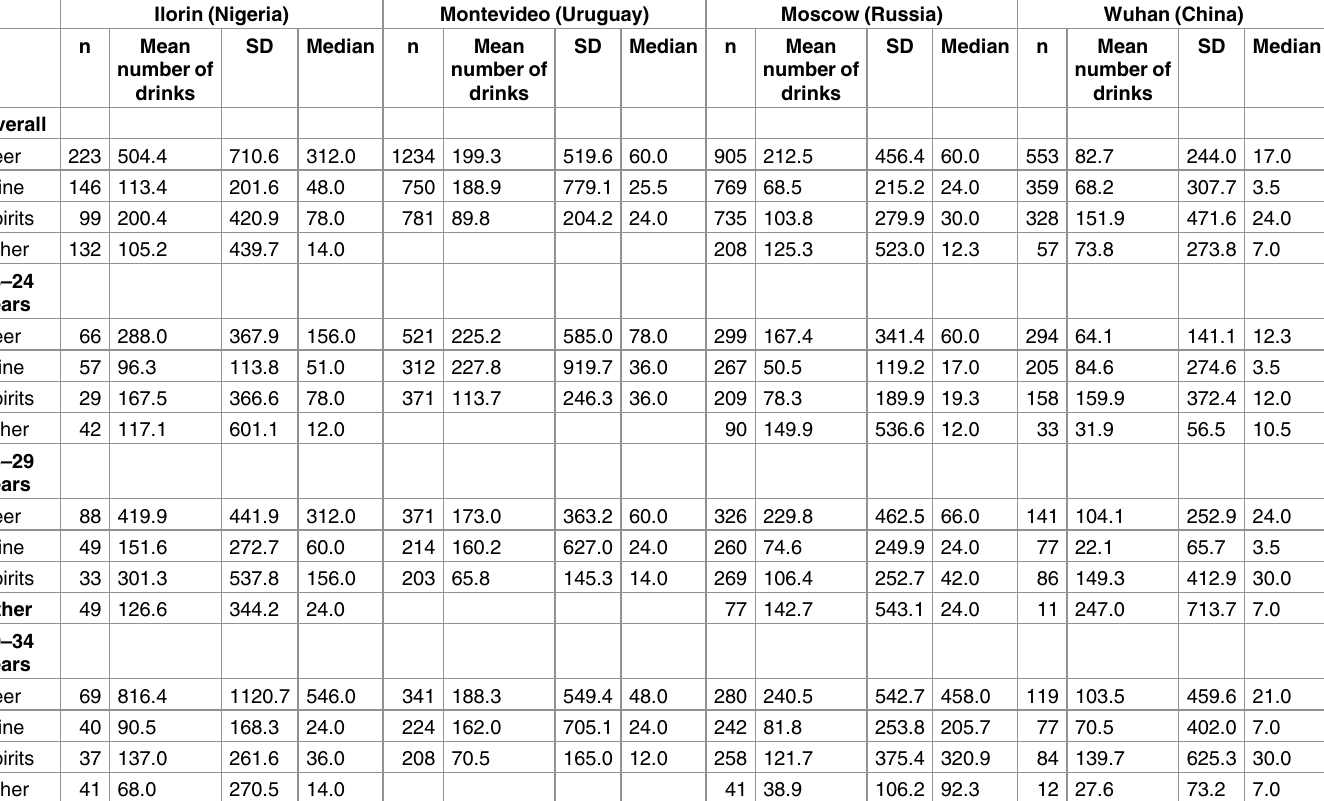
Table 5 details the BSQF (mean number of drinks consumed in the previous 12 months by type of alcohol (beer, wine, spirits and other)) for three different age groups. ‘Other’ was not asked in Montevideo. Beer drinking increased by age group for respondents in Ilorin and Mos- cow, while wine and spirits increased by age in Moscow. Overall, beer was consumed more in Ilorin, wine and beer in Montevideo and spirits in Ilorin with age group differences apparent. ‘Other’ alcohol (alcopops) was the highest consumption for Moscow. Fig 1 highlights the aver- age alcohol intake in grams per day for each city with increases apparent by age for Moscow and Ilorin. For current drinkers, average grams per day were 20.8 grams (SD 31.8 median 11.1 grams) for Ilorin, 14.6 grams (SD 33.0 median 4.3 grams) for Moscow, 13 grams (SD 36.1 Table 6 highlights the results of the final fully adjusted models for each city. Current drink- ers in Ilorin were more likely to be males, older, divorced or separated and less likely to be Muslim. In Montevideo current drinkers were more likely to be male, with higher levels of education and were less likely to be employed part-time and to cite their employment status as ‘other’. In Moscow current drinkers were more likely to be males, aged 25 to 29 years, higher educated and less likely to be Muslim and cite ‘other’ as their employment status. In Wuhan, current drinkers were more likely to be aged 25 to 29 years, divorced/separated or never mar- ried, with a middle level of education. Table 5. Descriptivestatistics of Beverage Specific Quantity Frequency (BSQF) (beers, wines and spirits) consumed in the last 12 months by age group and city/country^. Ilorin